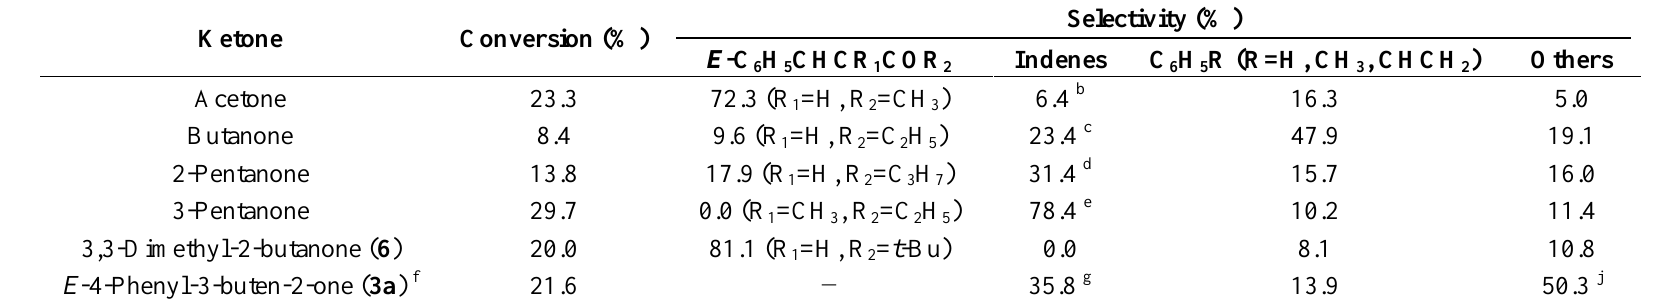
Cl )Cl (H O) ]·4H O/SiO 6 12 2 2 4 2